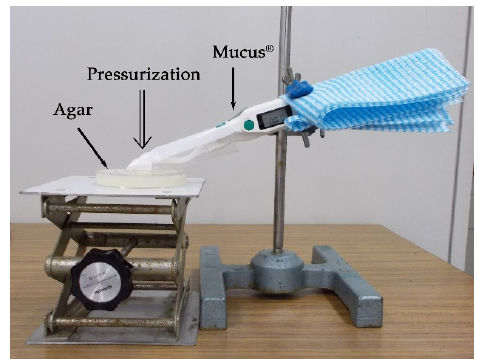
Figure 2. Measurement of agar